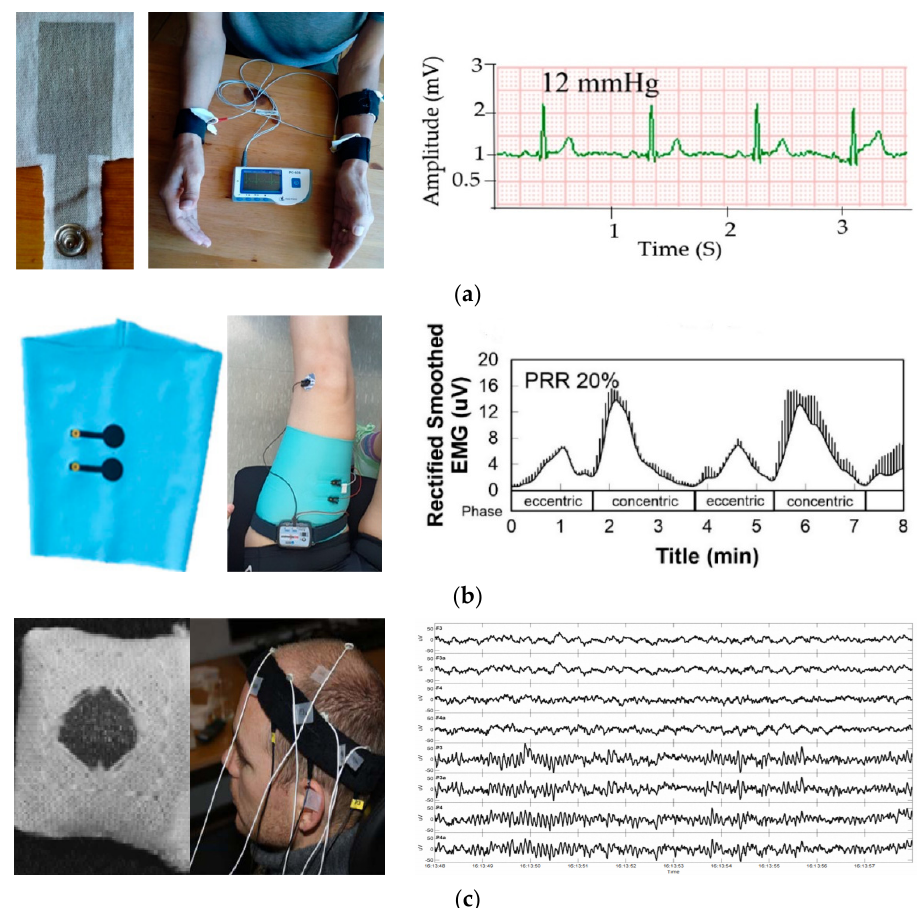
Figure 4. Textile-based bio-potential sensors: ( a ) silver-printed cotton electrocardiography elec- trode [13], under CC by 4.0; ( b ) silver and carbon paste conductive sheet electromyography elec- trodes laminated polyester/spandex sleeve [15], under CC by 4.0; ( c ) 15% nylon, 30% silver-plated conductive fibers, 20% Spandex, and 35% polypropylene knitted fabric electroencephalography electrode [16], under CC by